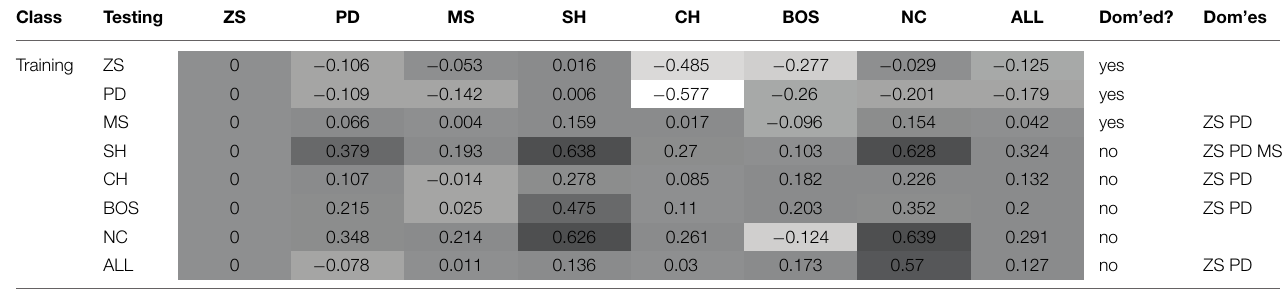
TABLE 4 | Mean payoffs (conditional on the training and test sets).